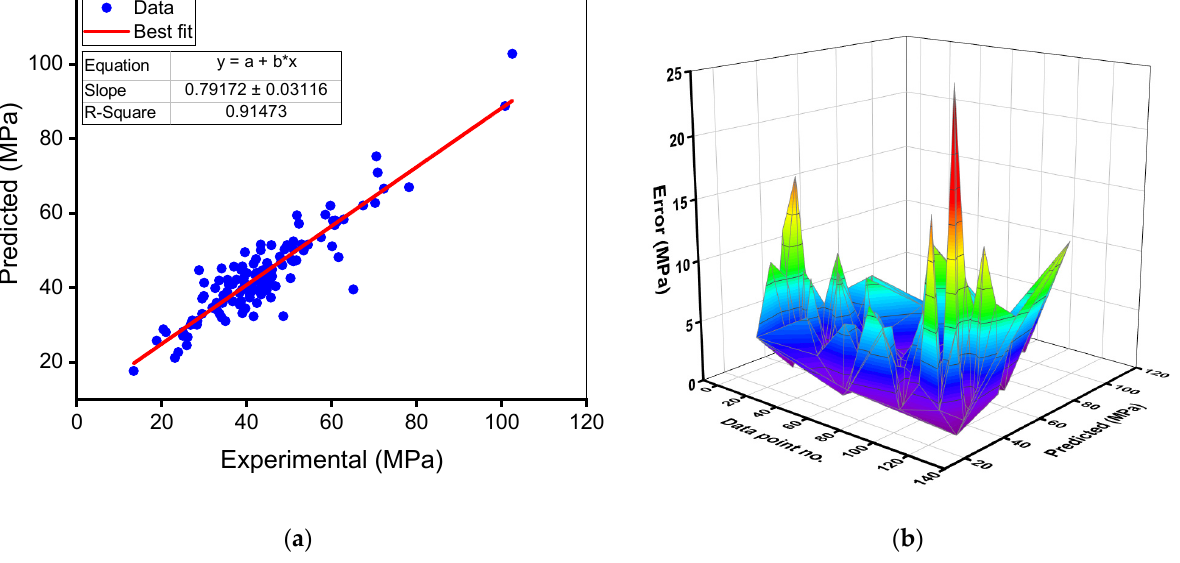
Figure 8. Random forest model for compressive strength: ( a ) relationship between experimental and predicted results; ( b ) spreading of predicted and error values.